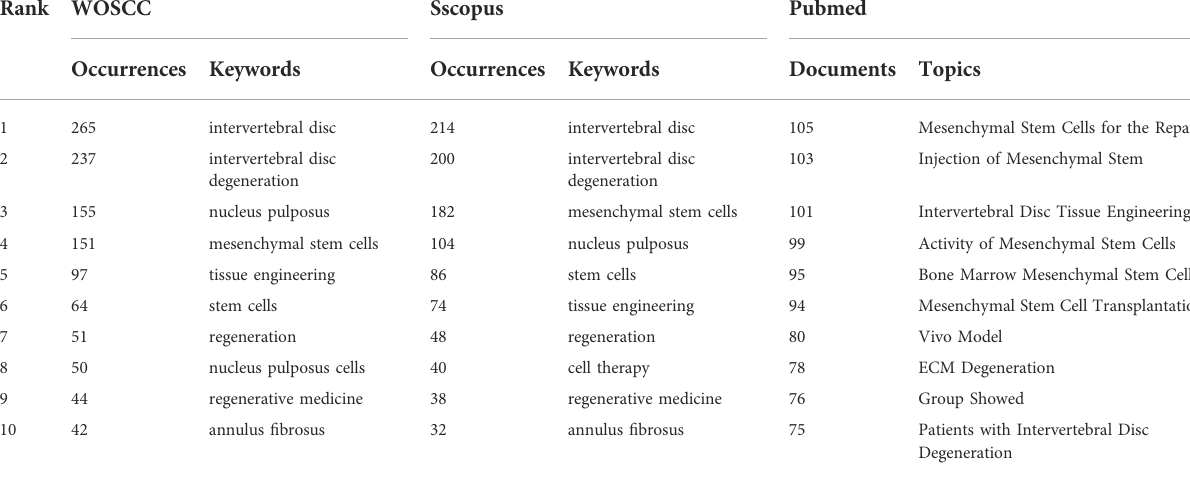
TABLE 6 Top 10 Keywords in the WOSCC, Scoups and Pubmed database. Rank WOSCC